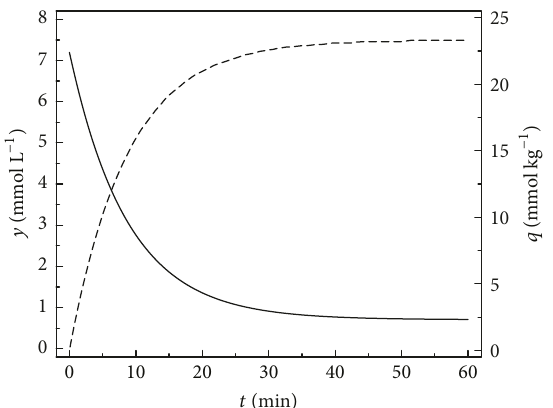
Figure 15: Plot of 𝑦 (solid line) and 𝑞 (dashed line) as a function of time in the adsorption column with recycle. 𝑊 Ads = 1334 kg, 𝑉 Feed = 240 L, 𝑉 Solv = 1800 L, 𝑦 Raff = 7.2 mmol L −1 , T = 30 ∘ C.